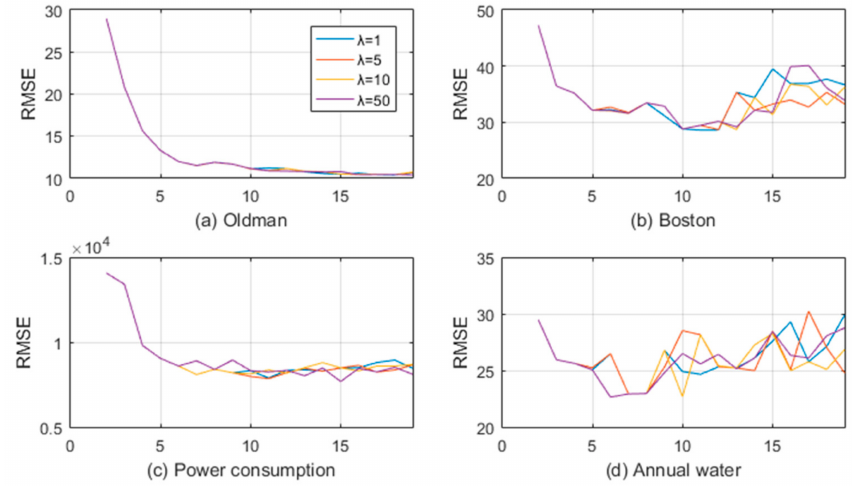
Figure 5. The experimental data. Different from the number of c which directly affects the precision of the least square fuzzy cognitive map (LSFCM) model, the values of λ do not have an apparent effect for the precision of the LSFCM model, but a large one for the weight matrix. The weight matrix varies linearly inversely with the shape parameter of sigmoid function λ . The results of the numerical experiments illustrate that various values of λ represent different W ∗ , but models with same performance are obtained. For the numerical example of the Births time series (f), the changes W with λ are as